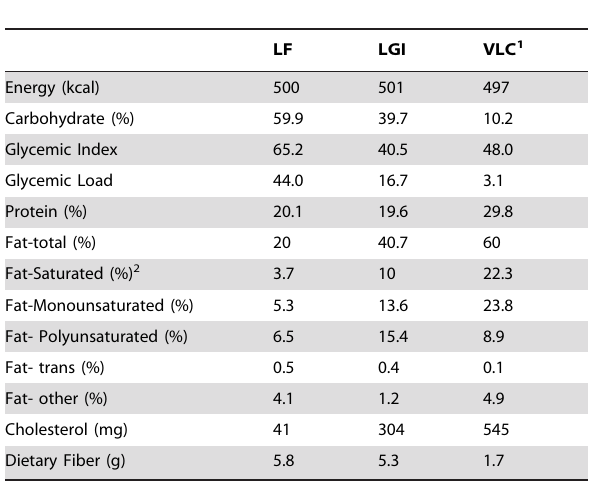
Table 2. Composition of standardized test meals for a 2000 kcal/day